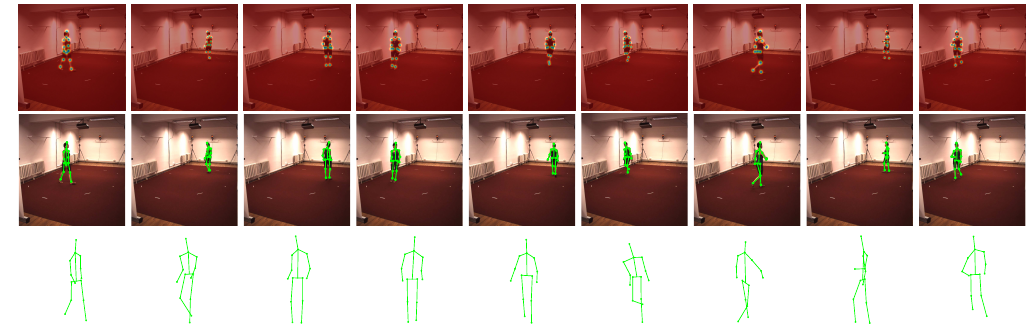
Figure 6. Evaluation on ’p3_ball_12’ sequence in UMPM. For five selected frames, our reconstruction (red skeleton), ground truth (green skeleton) and the corresponding image are shown on top. On the bottom, the reconstructions, yielded by all the baselines (blue skeleton) and our TUNS (red skeleton) of one specific frame, are shown with overlapping ground truth (green skeleton).